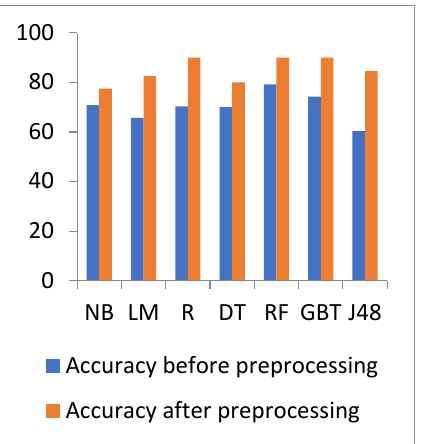
Figure 10. Accuracy comparison of different algorithms on general heath before and after prepro- cessing.